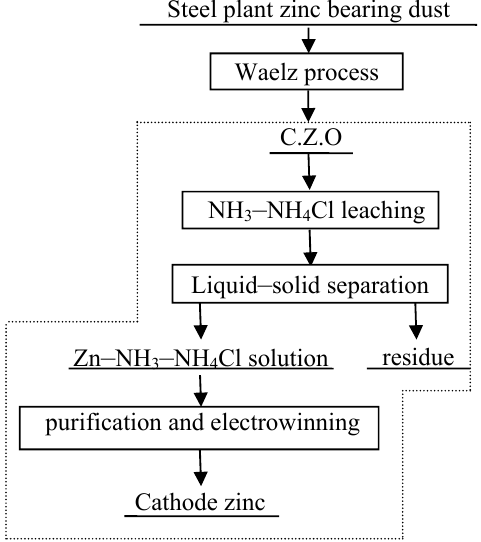
Figure 1. The principal flow sheet for extraction and recovery of high-purity zinc from steel plant zinc-bearing dust.